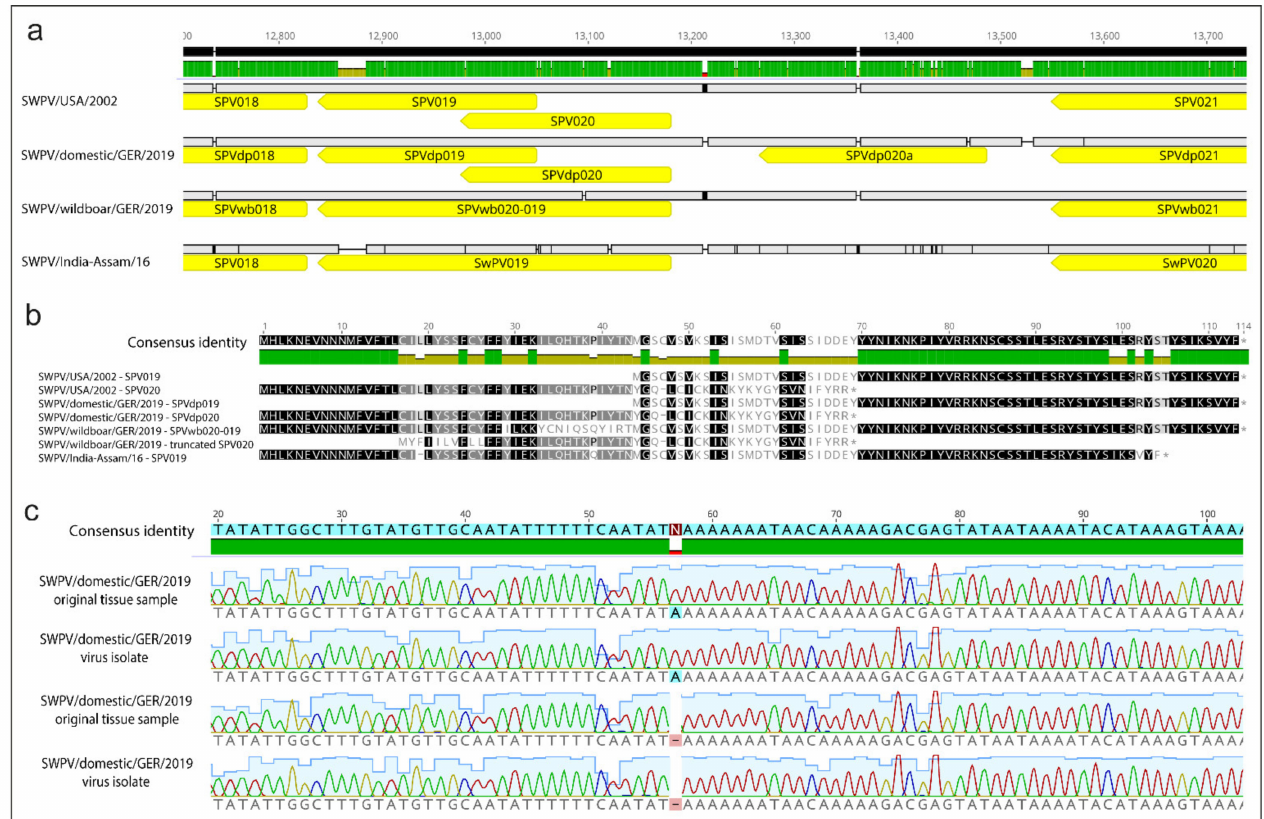
Figure 4. Analysis of SWPV specific genes in domestic pig and wild boar strains. ( a ) Schematic representation of the SPV019 and SPV020 ORFs present in different SWPV strains. Fusion of these genes via different single nucleotide deletions is apparent in the Indian domestic pig strain (SWPV/India-Assam/16, GenBank accession no. MW036632) and German wild boar SWPV strain (SWPV/wildboar/GER/2019, GenBank accession no. MZ773480). The SPV019 and SPV020 ORFs are present as separate overlapping ORFs in the American domestic pig strain (SWPV/USA/2002, GenBank accession no. NC_003389) and German domestic pig strain (SWPV/domestic/GER/2019, GenBank accession no. MZ773481). ( b ) Amino acid alignment between the SPV019 and SPV020 ORFs of different SWPV strains. A truncated variant of SPV020 is also present in the German wild boar SWPV genome and a novel ORF (SPVdp020a) exists downstream of SPV020 in the German domestic pig SWPV genome. ( c ) Analysis of DNA extracted from tissues samples from swinepox cases shows evidence of a single nucleotide deletion at position 13,096 bp in SPV020 ORF in the genome of a German wild boar SWPV strain from 2019 in both the virus isolate and the original tissue sample. This nucleotide deletion is not present in the isolate of the German domestic pig SWPV strain or in the original tissue sample. Alignments and analysis were performed using Geneious Prime (Biomatters, Ltd., Auckland, New Zealand).